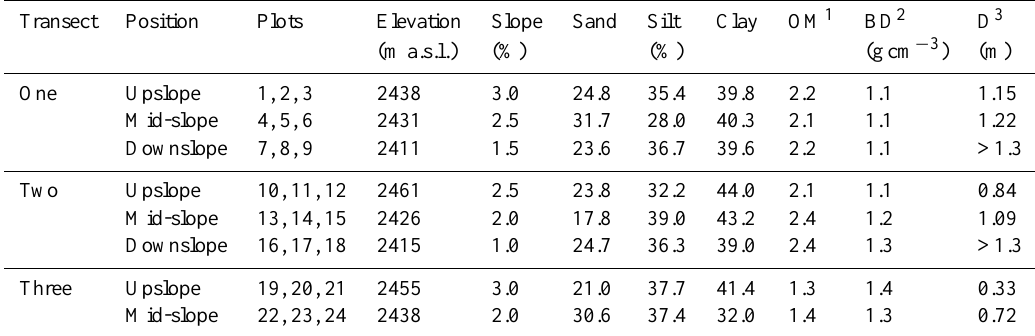
Table 1. Spatial attributes and soil properties of plots. Transect Position Plots Elevation Slope Sand Silt Clay OM 1 BD 2 D 3 (m a.s.l.) (%) (%) One Upslope 1, 2, 3